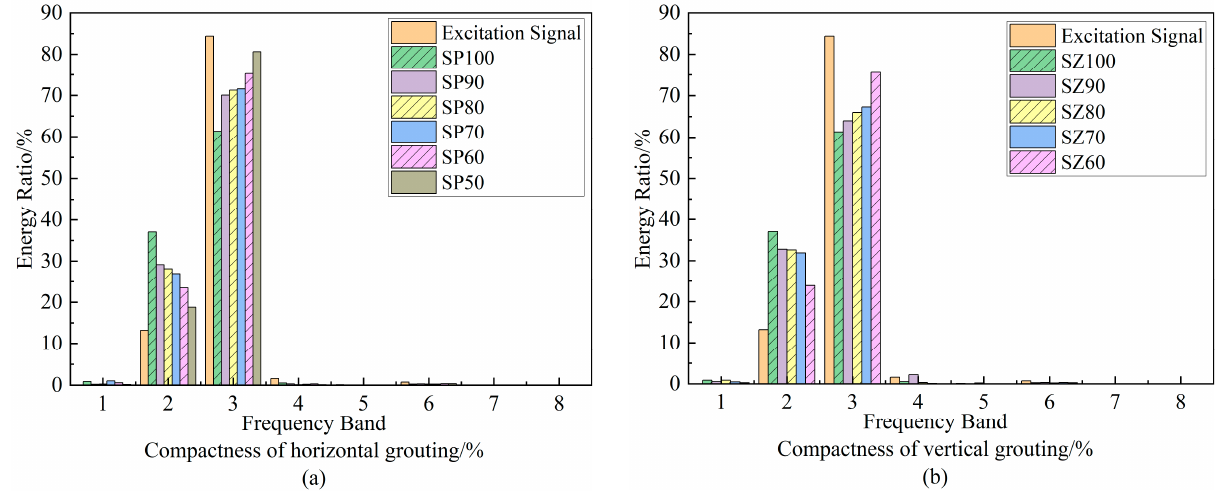
Figure 9. Relationship between wavelet packet energy proportion and grout saturation.